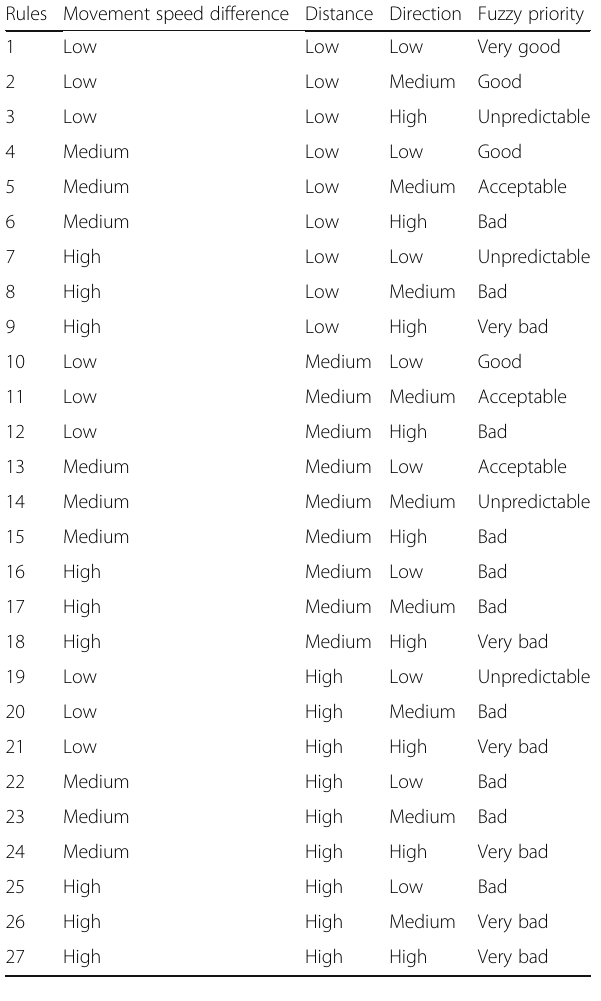
Table 3 Fuzzy rule used in TIHOO Rules Movement speed difference Distance Direction Fuzzy priority